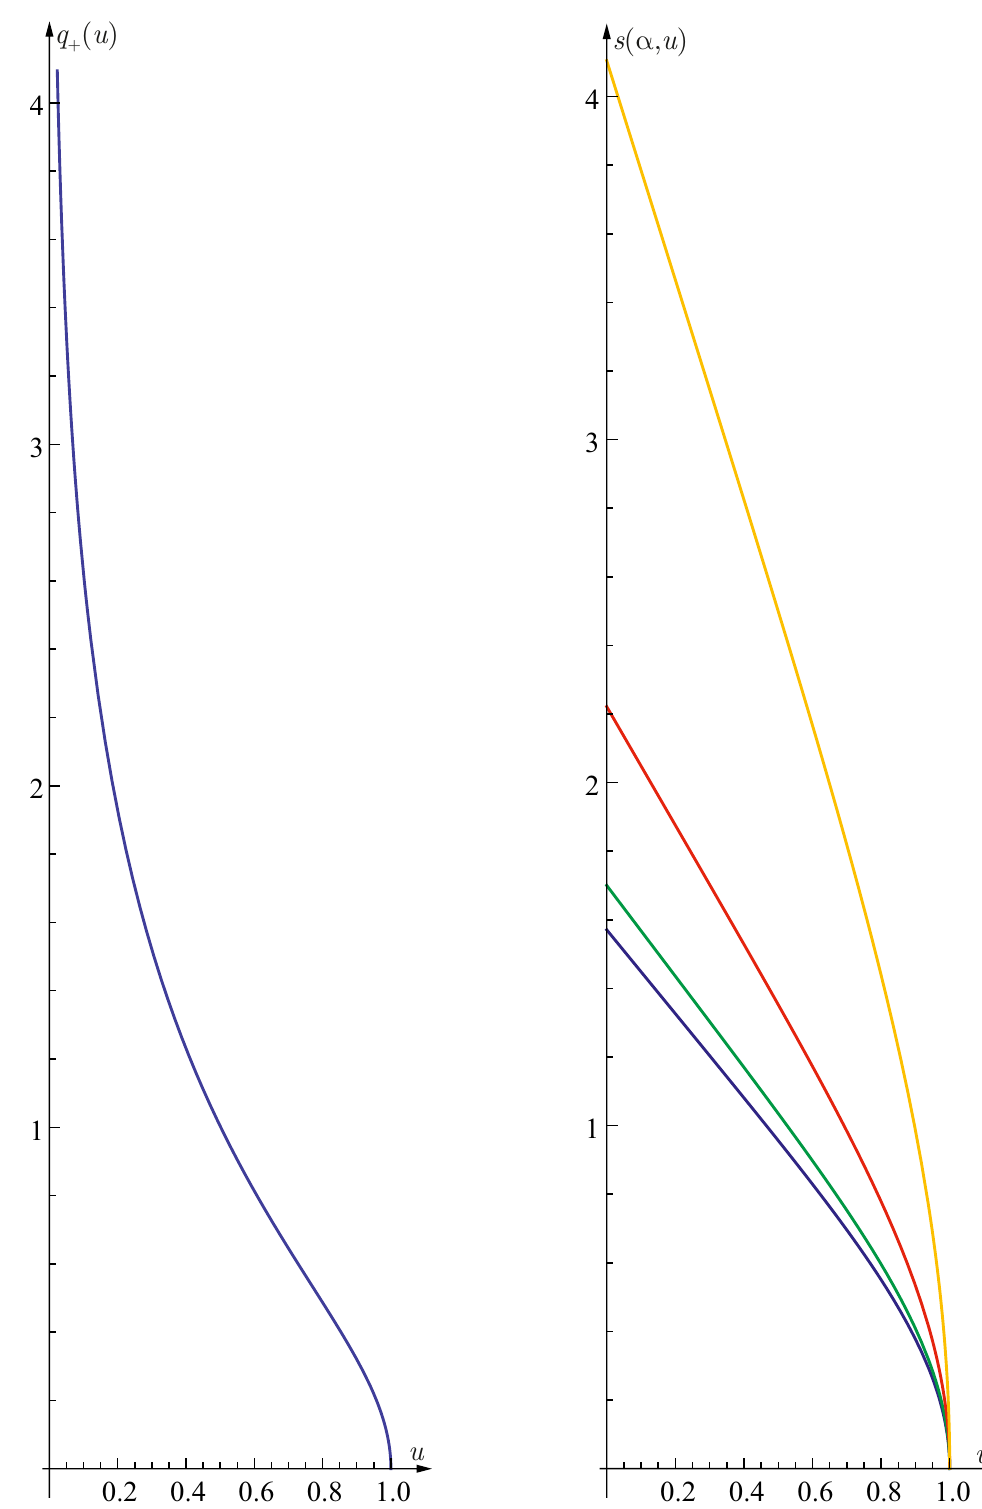
Figure 1. Dependencies q + ( u ) given by (5) calculated for the Northern Hemisphere and s ( α , u ) given by (13) with κ = 1 and λ geoid = 0.003348595 calculated for the chosen values of the azimuth α , i.e., α = 0 (blue line), α = π /8 (green line), α = π /4 (red line), and α = 3 π /8 (orange